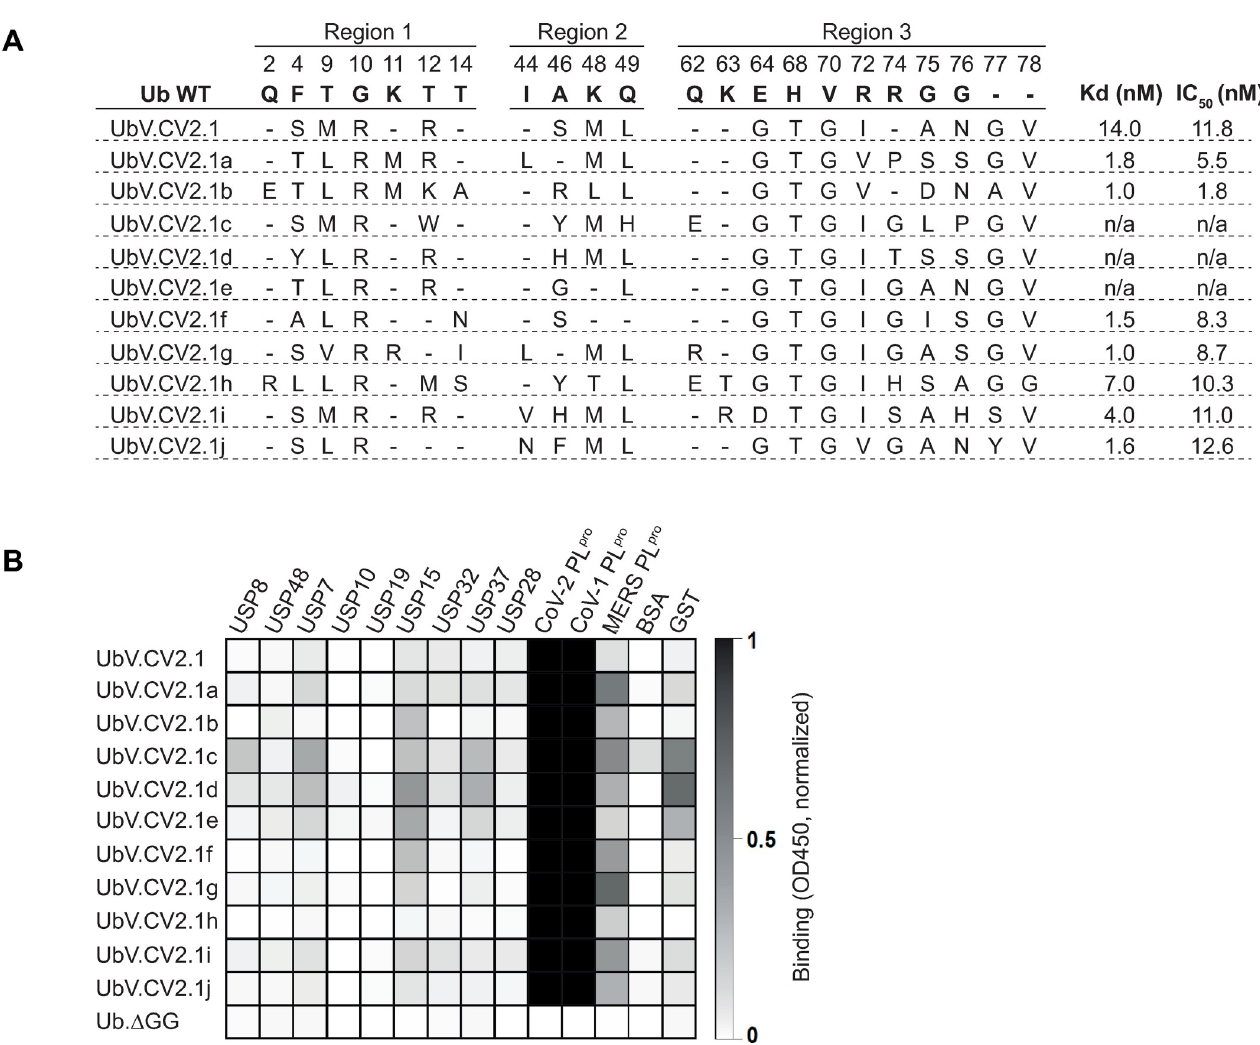
Fig 1. Engineered UbVs selected for binding to SARS-CoV-2 PLpro. (A) Sequence alignment of wt ubiquitin (Ub.wt) and UbVs selected for binding to SARS-CoV-2 PLpro. The residue numbers are shown at the top, and the alignment shows only those positions that were subjected to diversification in the phage-displayed UbV library. The dissociation constant (K D ) was measured using BLI with immobilized His 6 -GST-PLpro and solution-phase His- FLAG-UbVs. The inhibitory concentration 50 (IC 50 ) was calculated as the concentration of UbV required to cause 50% inhibition of hydrolysis of ISG15-AMC by PLpro , (B) The binding specificities of FLAG-tagged UbVs ( y-axis ) are shown across a group of 12 DUBs ( x-axis ), including 9 different human DUBs (USP7, USP8, USP10, USP15, USP19, USP28, USP31, USP37, and USP48) (x-axis), viral PLpro enzymes (SARS-CoV, MERS-CoV, and SARS-CoV-2), and two negative controls (GST and BSA), as assessed by protein ELISA. Purified His 6 -FLAG-UbVs were added to immobilized proteins as indicated and bound UbVs were detected by the addition of anti-FLAG-HRP and colorimetric development of TMB peroxidase substrate. The mean value of absorbance at 450 nm is shaded in a